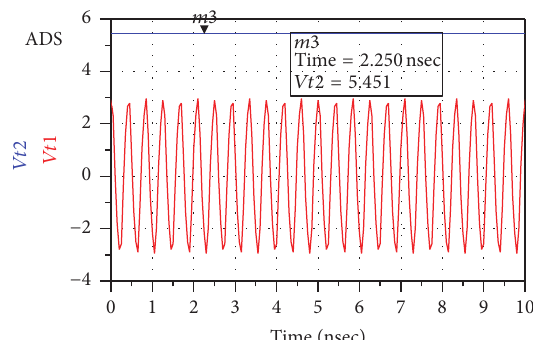
Figure 13: Efficiency of DBS.